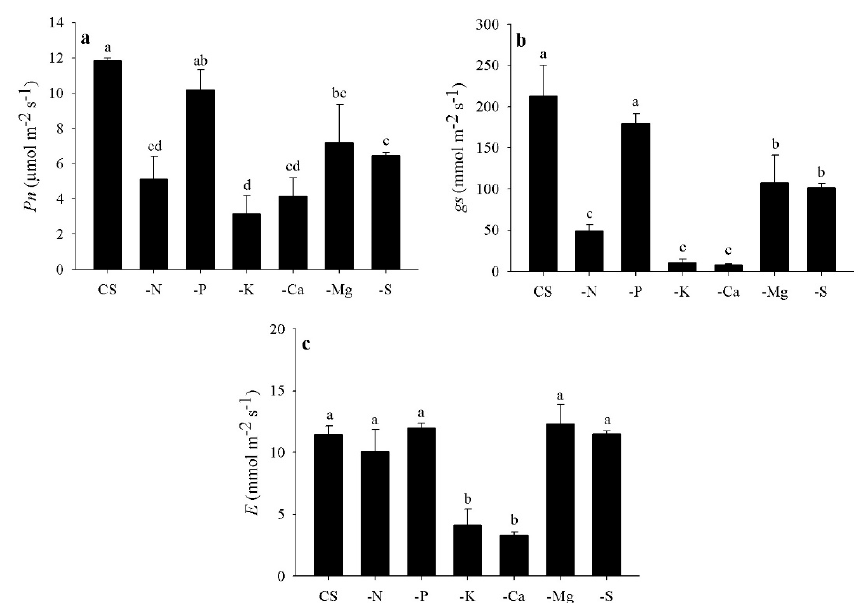
Figure 4. Net photosynthetic rate ( Pn ) ( a ), stomatal conductance ( gs ) ( b ) and transpiration rate ( E ) ( c ) of broccoli ( Brassica oleracea var. italica L.) plants cultivated with a complete nutrient solution (CS) and under the omission of macronutrients (-N, -P, -K, -Ca, -Mg and -S). Mean values (column) followed by different letters indicate statistically significant difference by the Tukey test ( p ≤